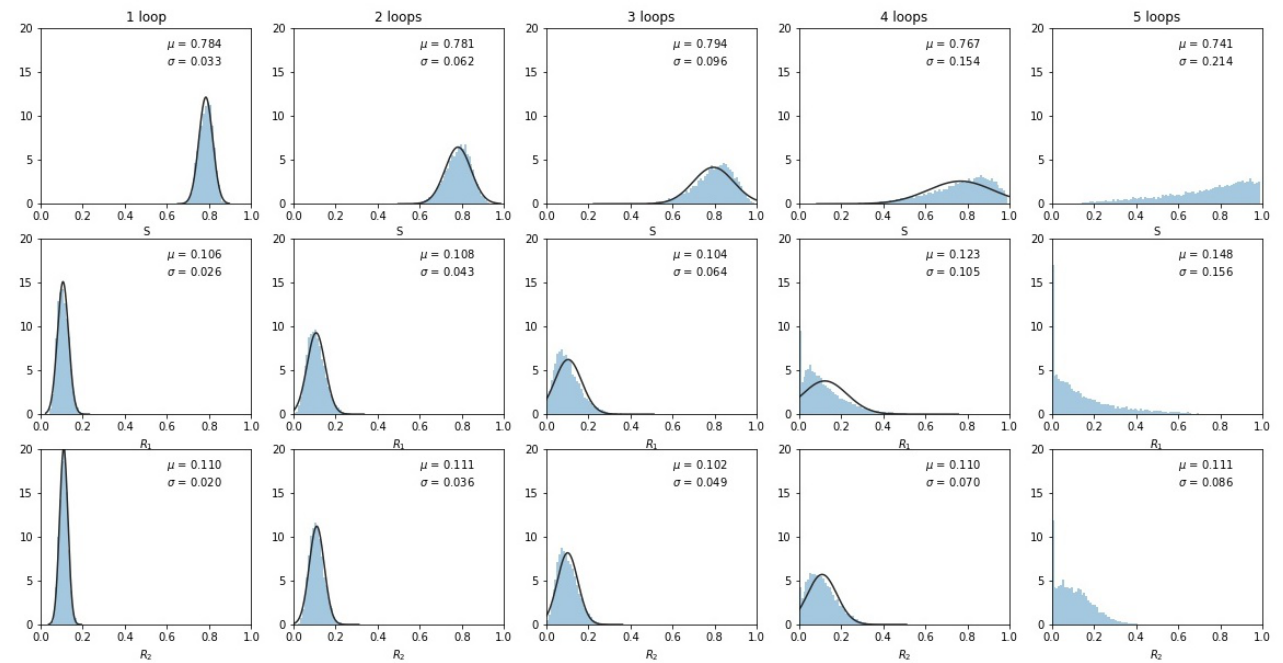
Figure 5. Histogrammed distributions of the three sub-populations as the number of loops increases. Note that some tumors began to fill at the S = 1 and R 1 = 1 corners, distorting the multivariate Gaussian nature of the distributions. Mean µ and standard deviations σ are